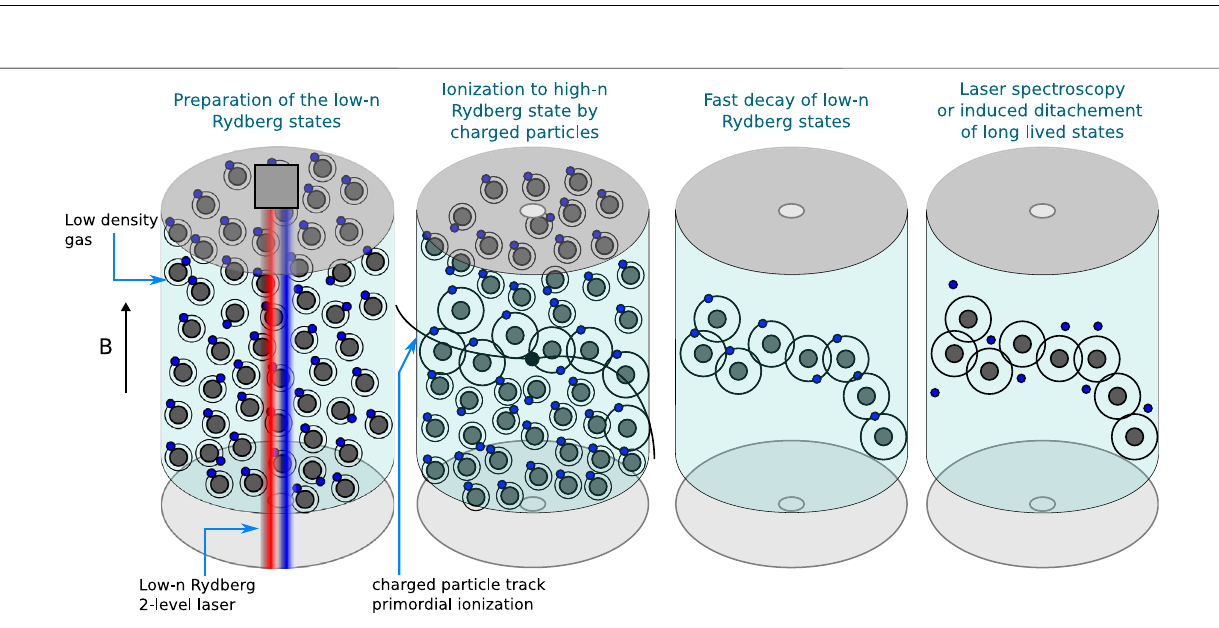
FIGURE5 | Schemeof aprojection chamber with aRydberg transducer of theEM pulses produced inthe ampli fi cation region and which are upconverted into the visible domain for optical readout. The ampli fi cation region furthermore produces an enhanced number of avalanche electrons due to the low ionization threshold of the Rydbergatoms.Theatomsareexcitedbyatwo-levellasersystem.Therestofthechamberfollowsaclassicaldesignwithamagnetic fi eldtosensetheLorentzforceand the homogeneous electric fi eld to transport the electrons and ions from the primordial ionization region to the ampli fi cation region.